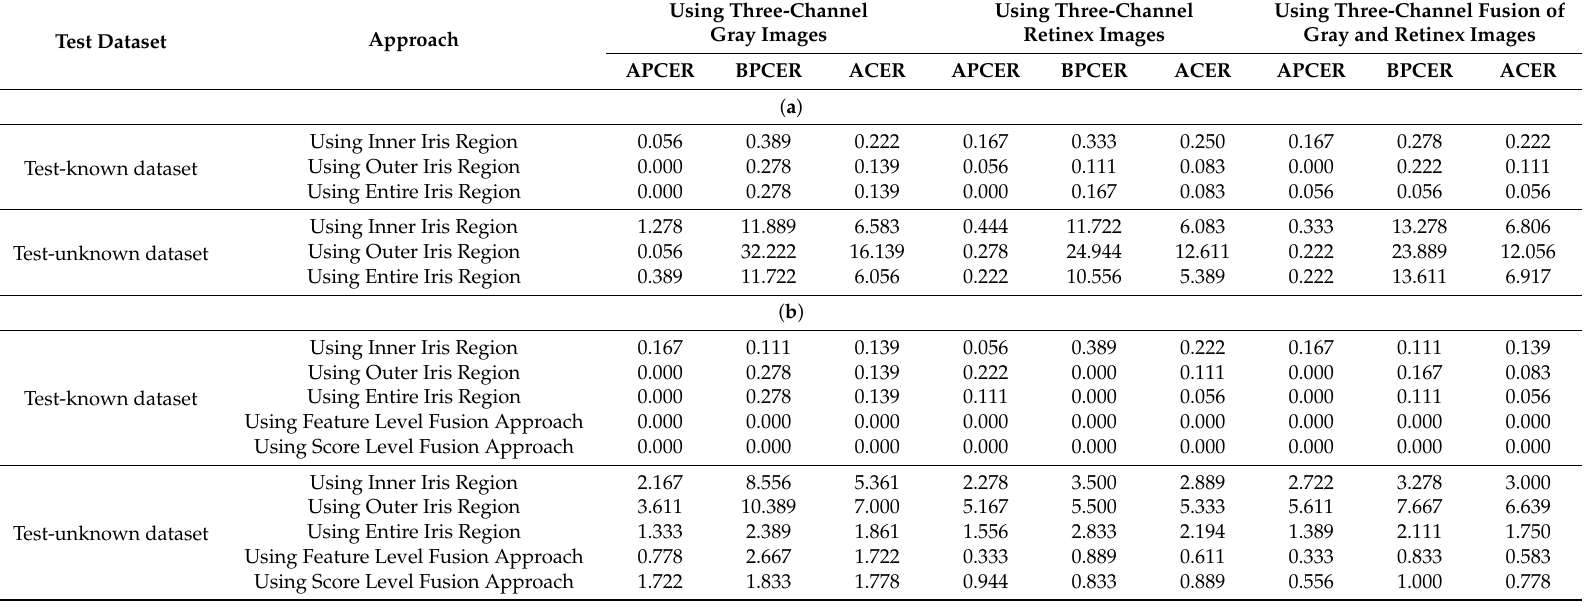
Table 7. (a) Detection errors (APCER, BPCER, and ACER) of iPAD based on CNN method for classification using NDCLD-2015 dataset with